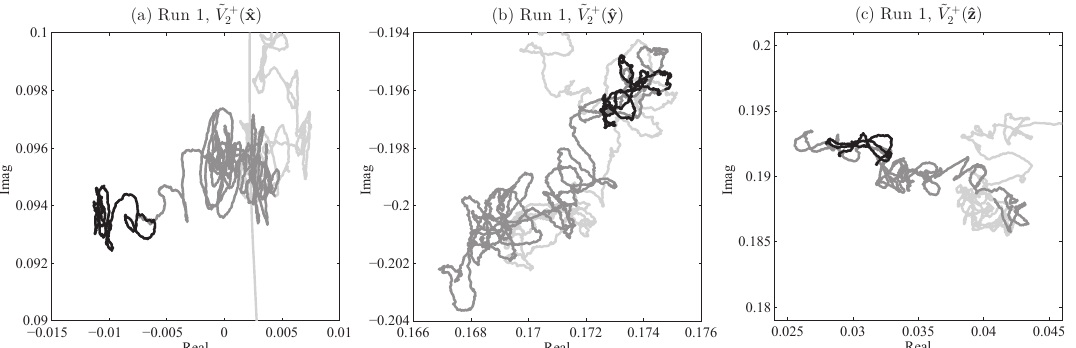
( ˆ k , t ) , ˆ k = ( a ) ˆ x , ( b ) ˆ y and ( c ) ˆ z , from Run 1; these are the Figure 12. Close-up phase portraits of ˜ V + 2 ends of the trajectories shown in Figure 11. (The variables are normalized by N 3/2 , N = 128.) Light gray is part of the full trajectory, while dark gray is the last half of the trajectory, i.e., from 0.5 t end to ( ˆ k , t ) = ˜ b + ( ˆ k , t ) . t end , and the black part is from 0.9 t end to t end . In these figures, ˜ V + 2